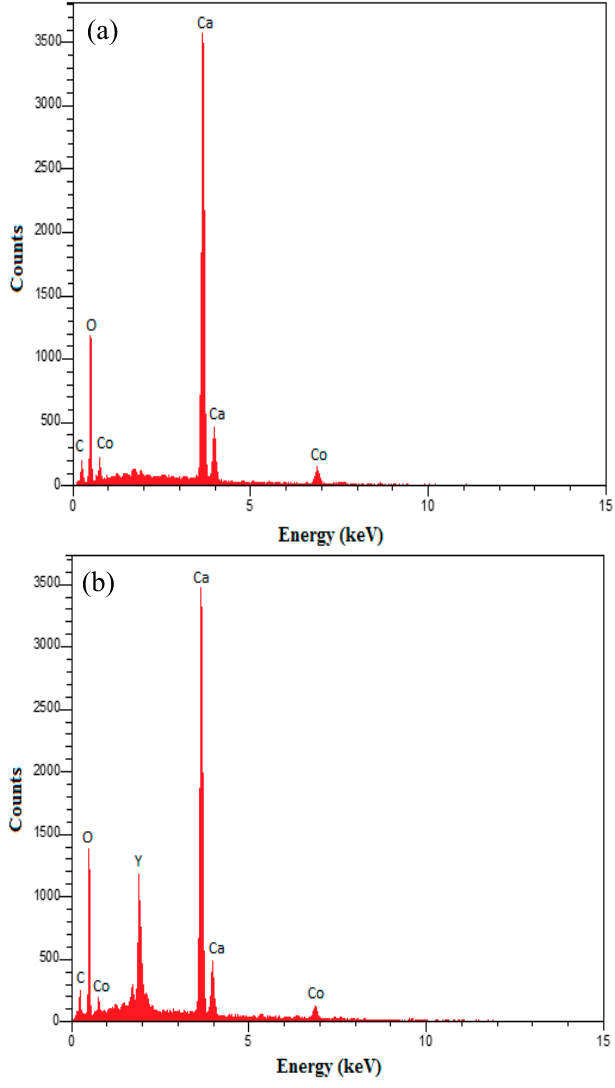
Figure 12. EDX analysis of used: ( a ) Ca ‐ 9Co; and ( b ) Ca ‐ 9Co ‐ 4.5Y.